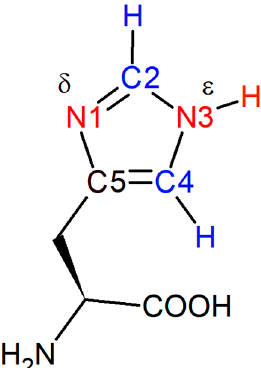
Figure 1. Histidine with carbon atoms 2 and 4 (blue) and δ - and ε -nitrogen atoms (red) on the imidazole ring. The pKa of the protonated δ -nitrogen is near neutral, and the chemical shifts of protons attached to C2 and C4 in 1 H NMR spectroscopy are frequently used to determine its pKa.